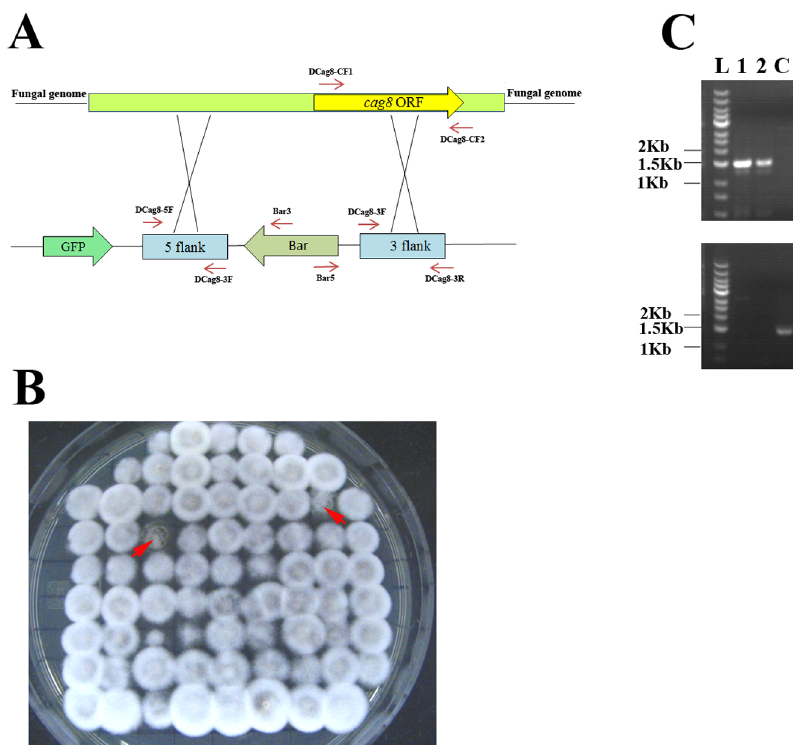
Figure 3. Disruption of Cag8 in D MrKu70 using the bar gene as the selection marker. ( A ) the Cag8 disruption plasmid (pPK2-OSCAR-GFP- Cag8) and the relative position of Cag8 in D MrKu70 . ( B ) The representative 74 of 301 glufosinate ammonium-resistant transformants randomly selected from fungal transformation plates for Cag8 disruption in D MrKu70 . Arrows indicate colonies with conidiation, and the remaining 72 transformants show the fluffy phenotype without conidiation. ( C ) Two fluffy colonies were randomly selected from the transformation (B) (labeled as 1 and 2) for confirmation of Cag8 disruption in D MrKu70 . Top panel: PCR conducted with the primers Bar5 and Cag8CF2, PCR products can be obtained only from D Cag8: D MrKu70 mutants; Bottom panel: PCR conducted using primers Cag8CF1 and Cag8CF2, and PCR products can be obtained in any strain other than D Cag8: D MrKu70 mutants. L: DNA ladder (DL 10004) from Generay (Shanghai, China).